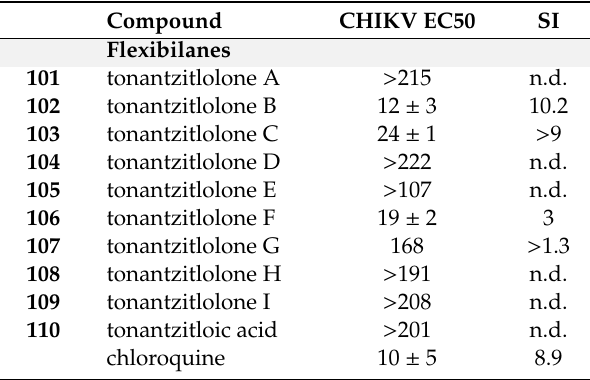
Figure 6. Structures of flexibilanes 101 – 110 . Table 5. Anti-CHIKV activities of flexibilanes 101 – 110 .